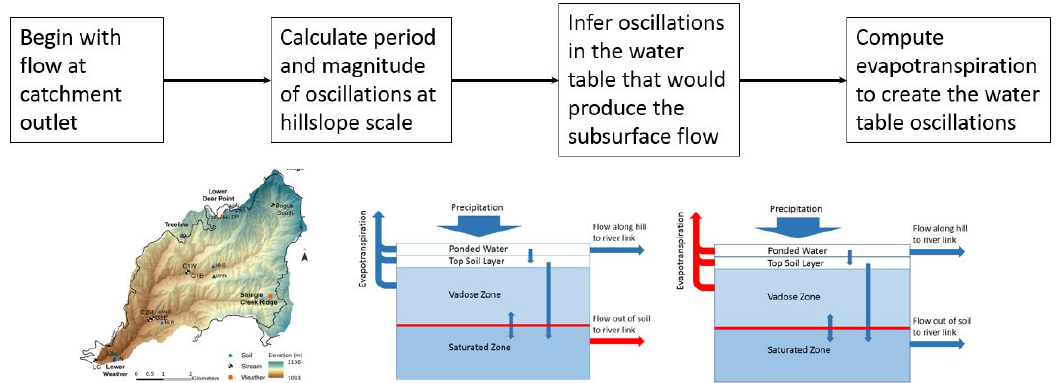
Figure 3. An overview of the processes described in Sections 2 to 4.